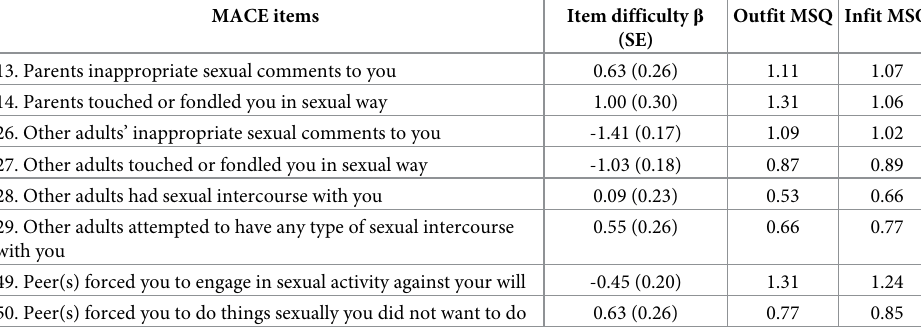
Table 6. Rasch analysis of sexual abuse subscale.